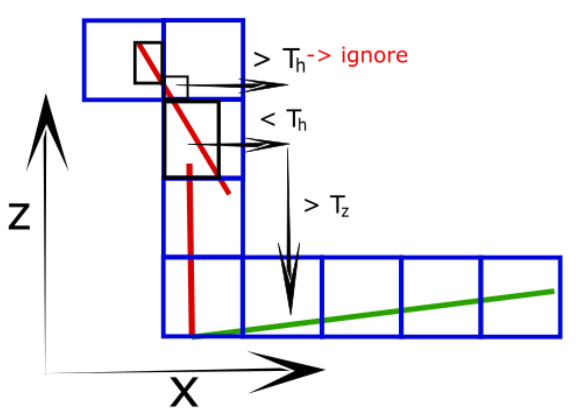
Figure 4. Profile of the gradient calculation, green line: ground, red line: building. Blue boxes shows the voxel from the octree and black boxes the sub bounding boxes. The horizontal distance defines usable neighbours and the vertical distance defines the gradient